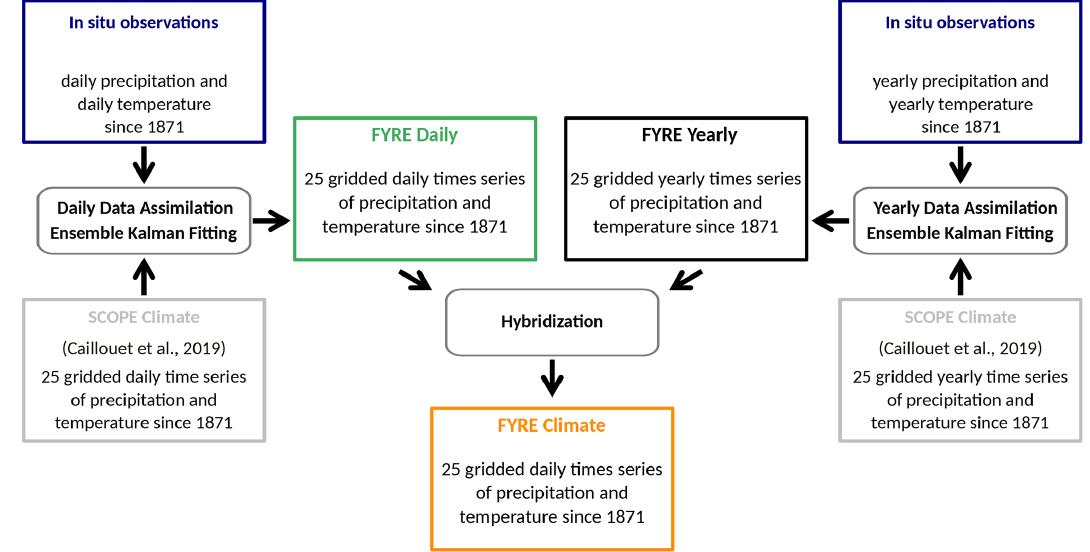
Figure 4. Production scheme of the different reanalyses. Details can be found in Sect. 3.6.